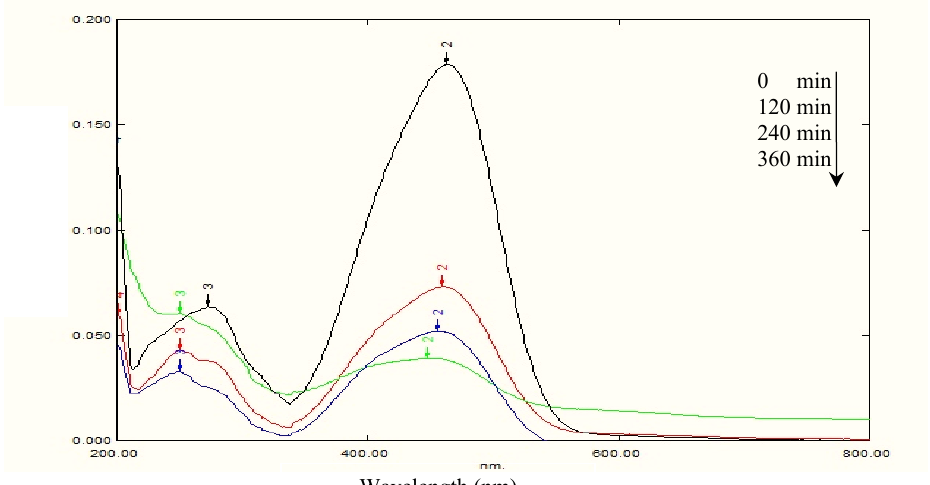
Fig. 4: Absorption spectra of MO degraded by TiO